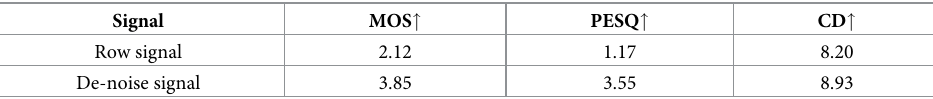
Table 1. MOS standard comparison table. Signal MOS " PESQ "